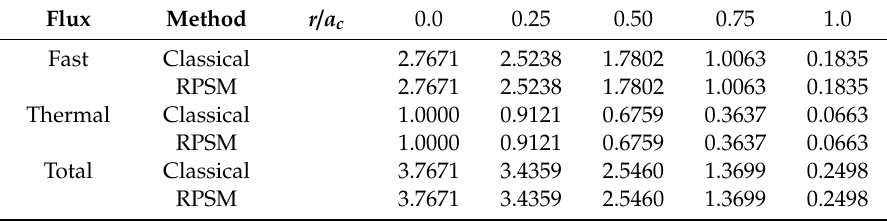
Table 4. The normalized thermal, fast and total fluxes in a spherical